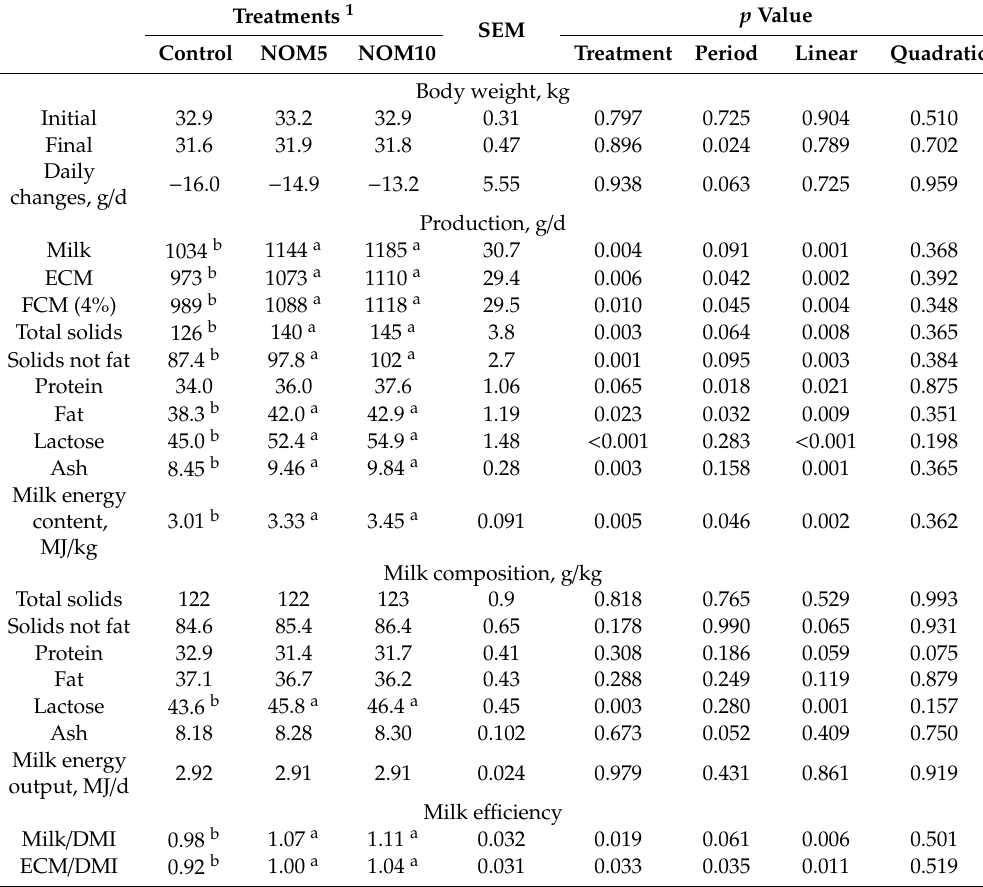
Table 3. Weight changes, milk production and composition of lactating Nubian goats fed a basal diet supplemented with N. oculata